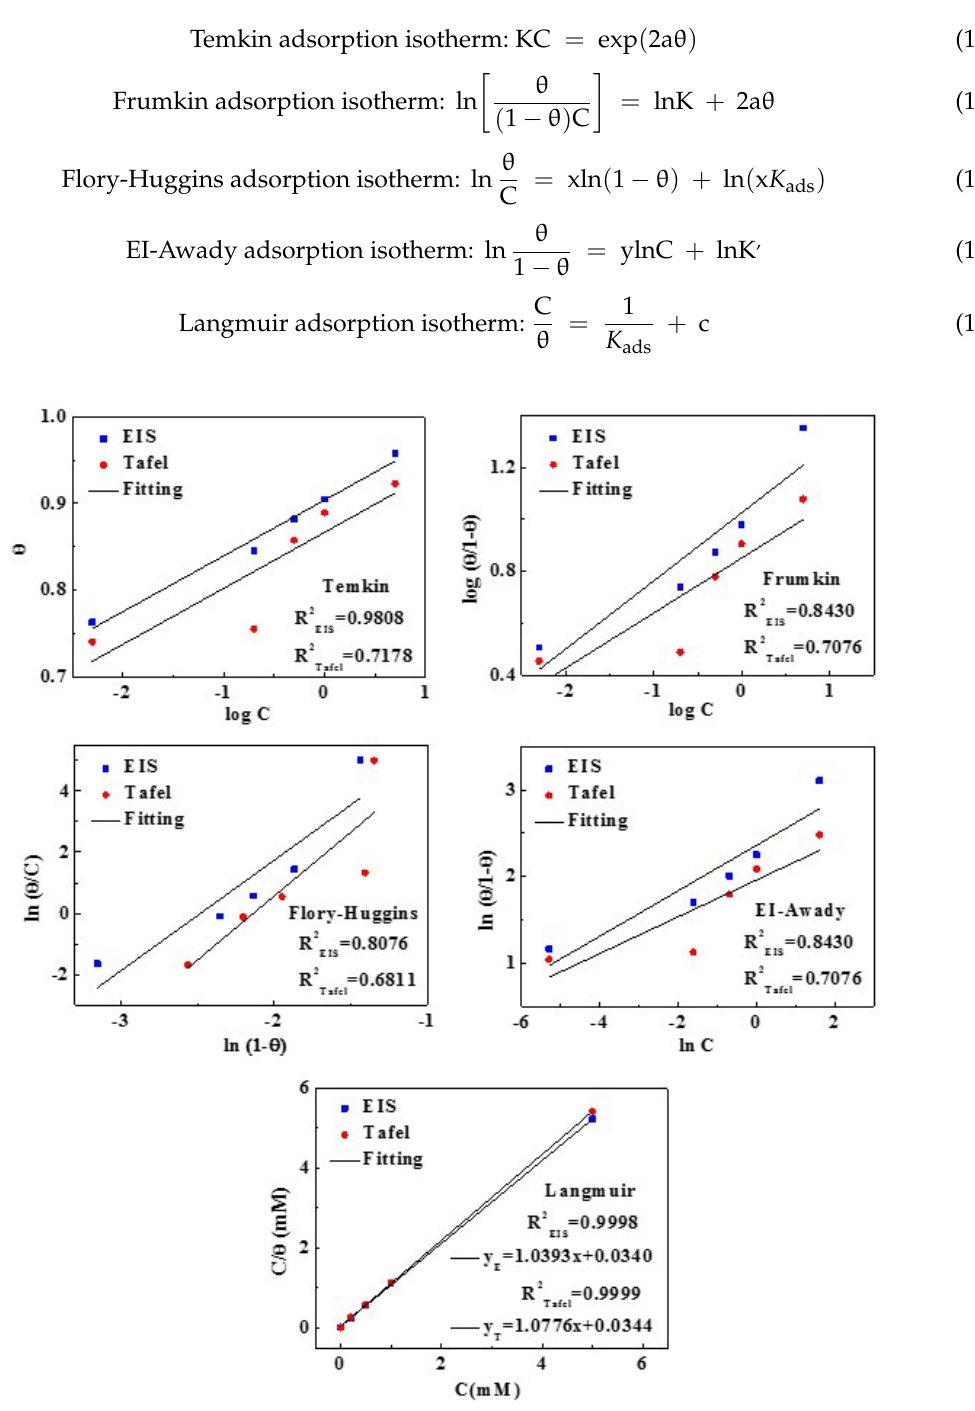
Figure 10. The various adsorption models fitting of MTT on copper surface.